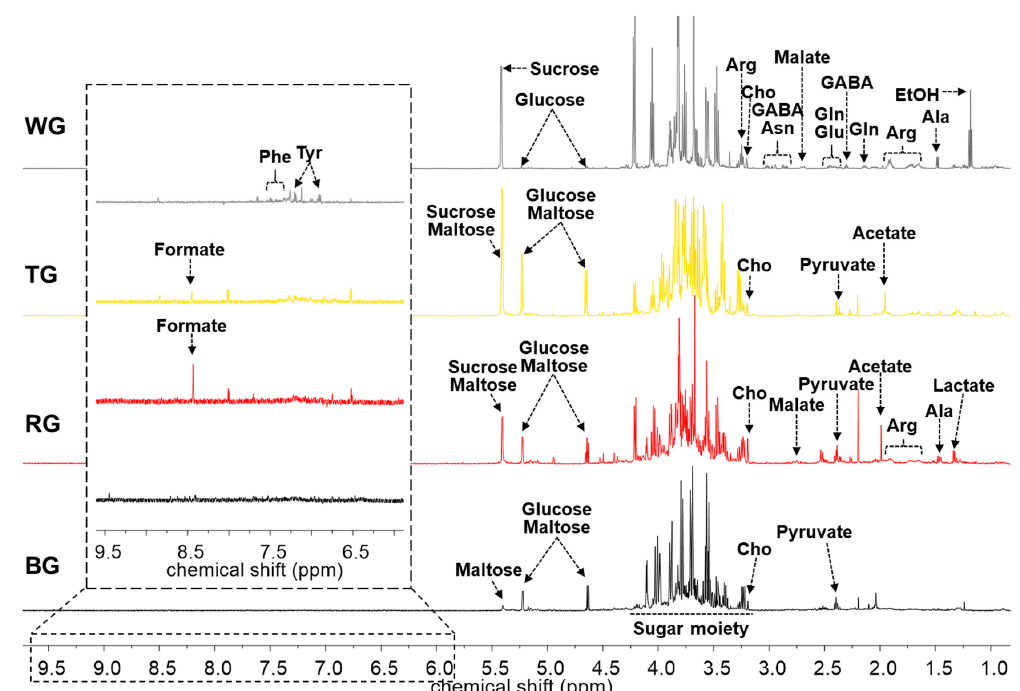
Figure 1. Representative 600 MHz 1 H HR-MAS NMR spectra of four processed ginseng products. WG,